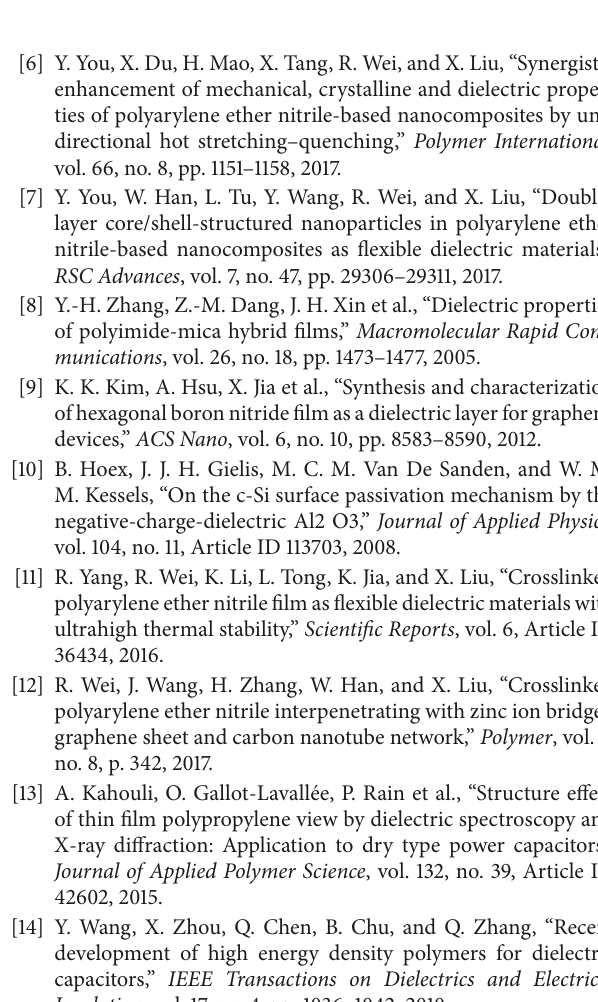
Figure 8: Dielectric constant (a) and dielectric loss (b) of the PAZ, PAZ-NT, and